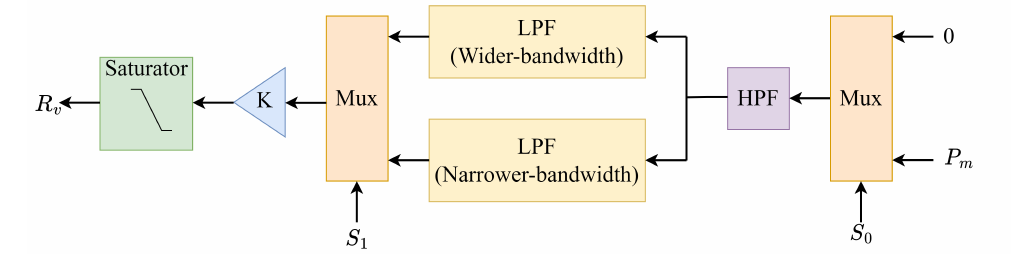
Figure 28. Adaptive virtual resistance operation